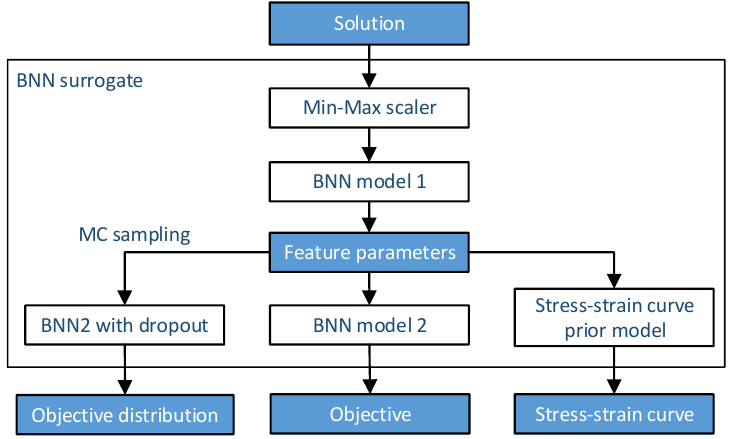
Figure 4. Schematic diagram of BNN surrogate model.